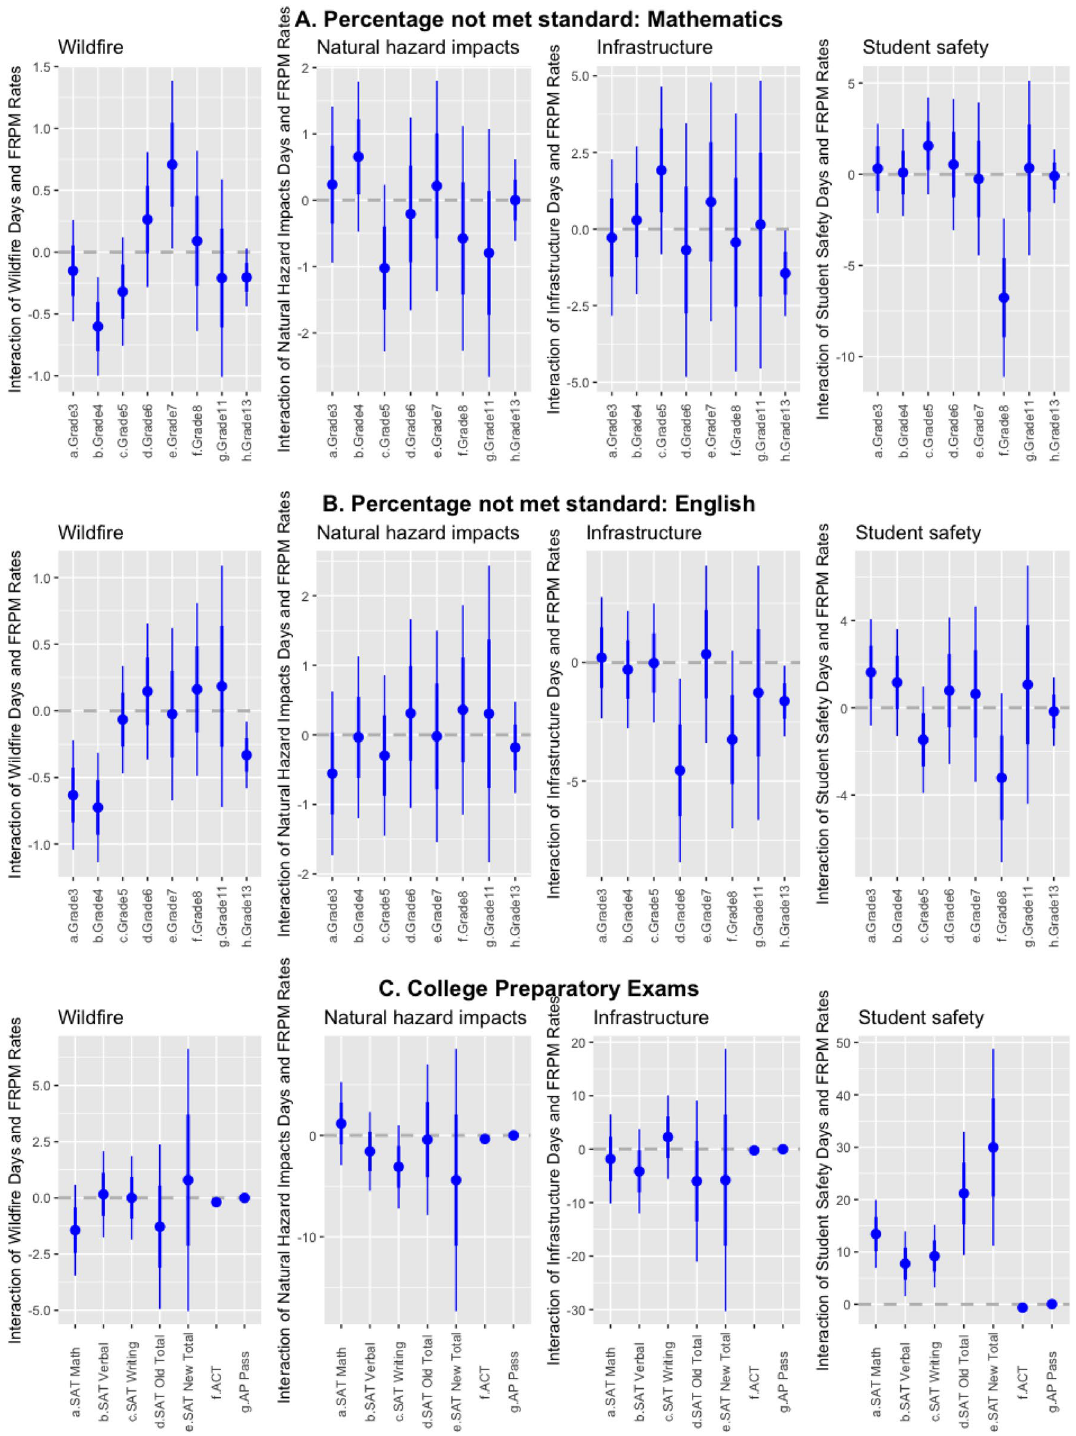
Figure 3. Effect of school closures caused by the interaction of closures and FRPM rates by closure cause on standardized test scores for ( a ) grades 3–11 and all grades (grade 13) for mathematics, ( b ) grades 3–11 and all grades (grade 13) for English, and ( c ) college standardized exams. Lines indicate confidence intervals two standard deviations from the mean. Note that the y-axis scale varies among